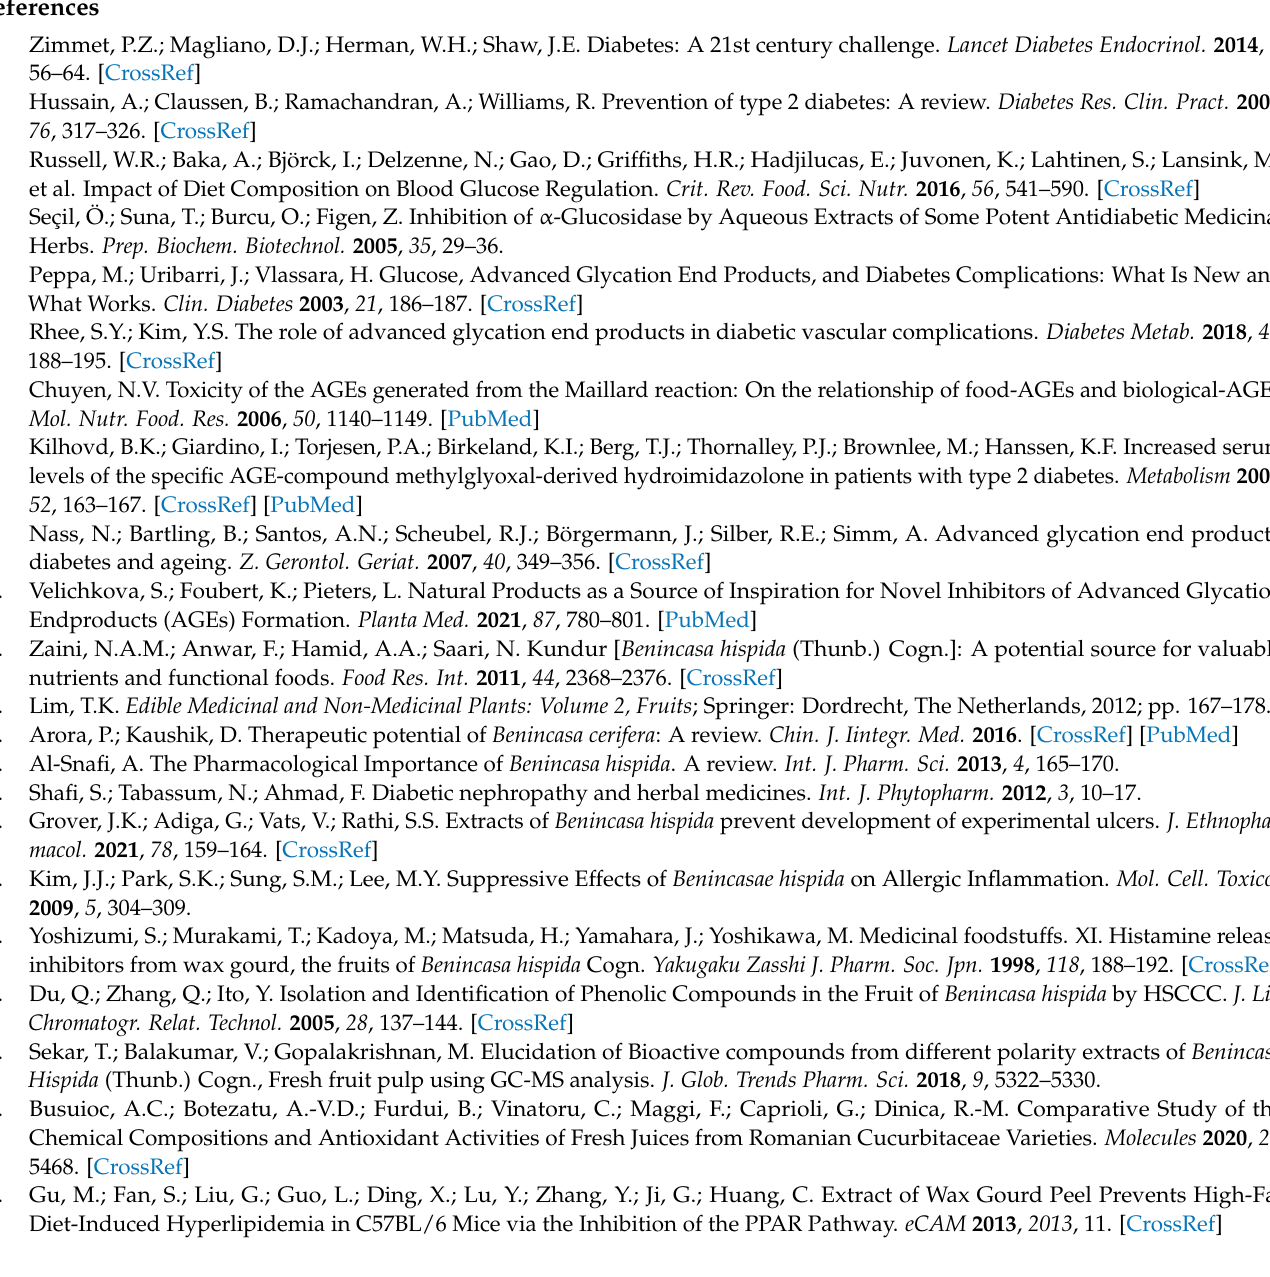
Supplementary Materials: The following are available online. Figures S1–S33: NMR and MS data of Table S2: Robustness of compounds ( 1 – 11 ) under various analytical